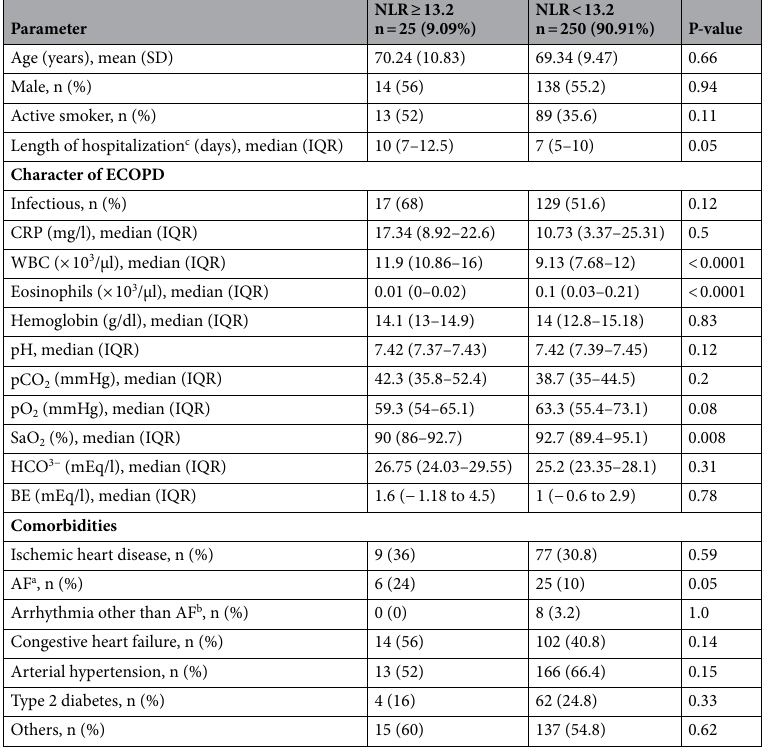
Table 3. Study parameters upon stratification by NLR value. AF atrial fibrillation, CRP c-reactive protein, IQR interquartile range, WBC white blood count. a First detected in the admission, paroxysmal, persistent or permanent. b In the admission or in the past medical history. c Among